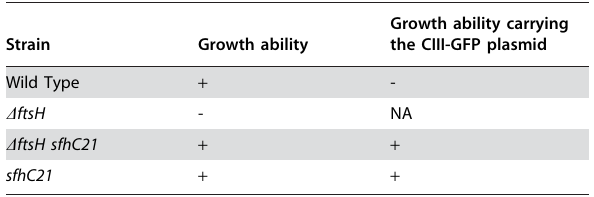
The ability to grow on LB plates was tested in a set of isogenic strains of W3110 (Wild Type strain). To these strain the CIII-GFP plasmid was inserted by electroporation and the ability to form ampicillin resistant colonies was tested either at 30 u C or 37 u C by plating on LB plates with 100 m g/ml ampicillin in the absence of arabinose. The plus sign represent growth whereas the minus sign represents failure to grow. NA–not applicable.